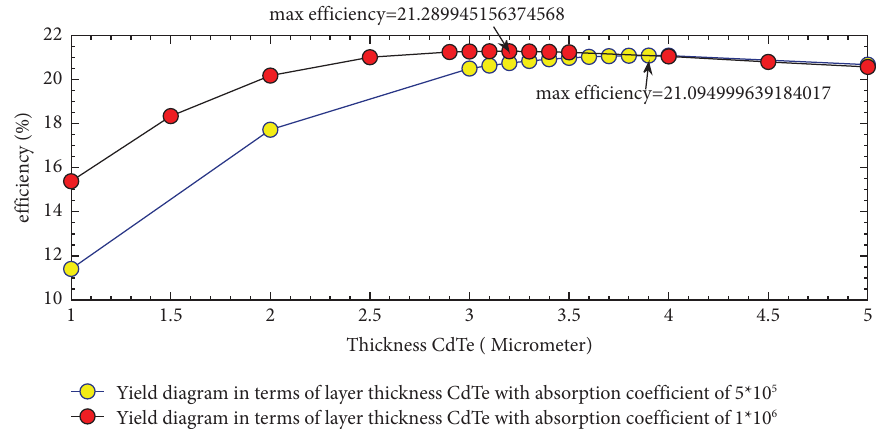
Figure 12: Performance diagram in terms of CdTe layer thickness in two modes with diferent absorption coefcients.